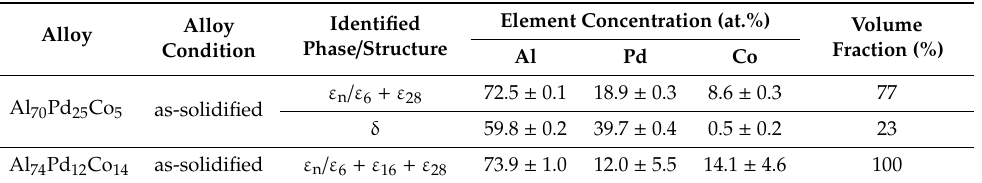
Figure 3. XRD diffraction patterns of as-solidified Al 70 Pd 25 Co 5 ( a ) and Al 74 Pd 12 Co 14 ( b ) alloys. Table 2. Metal concentrations and phase assignments of microstructure constituents observed in as-solidified Al 70 Pd 25 Co 5 and Al 74 Pd 12 Co 14 alloys.